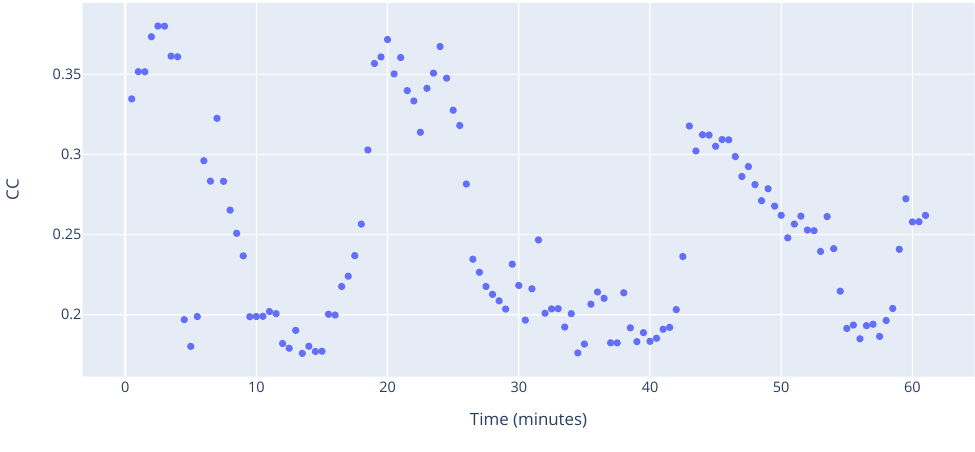
Figure 17. Clustering coefficient.